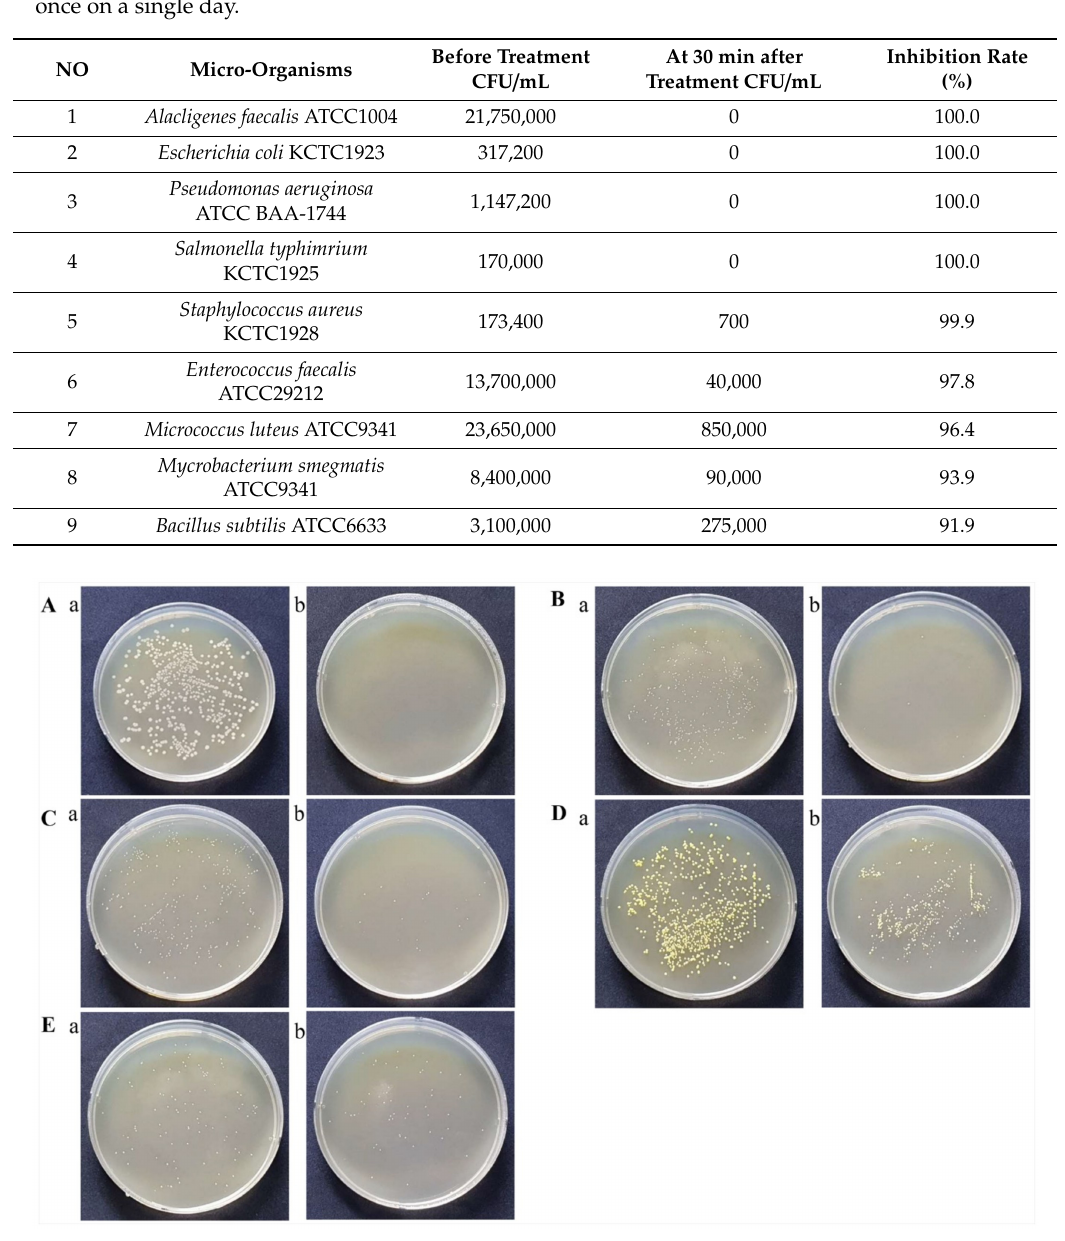
Table 1. Inhibition rate of Puriton ® against nine pathogenic bacteria. This experiment was conducted once on a single day.